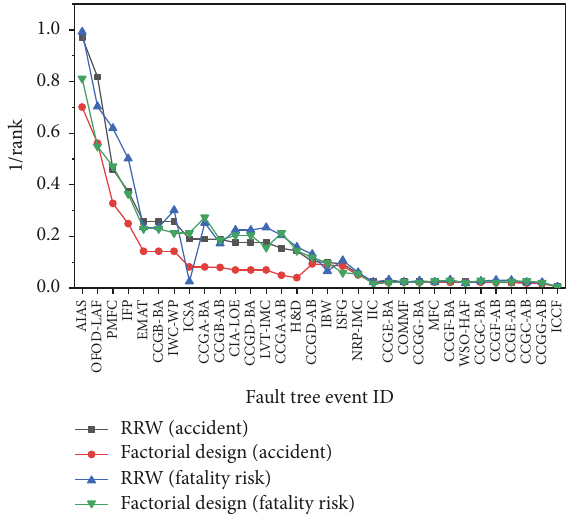
Figure 13: Comparison of fatality versus accident